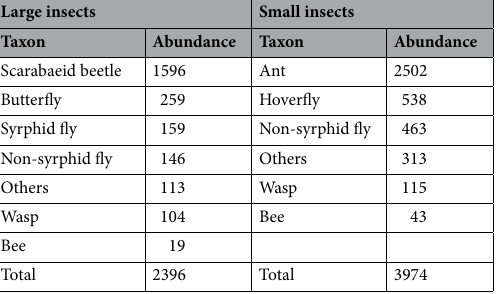
Table 1. Taxonomic composition of large and small insects observed visiting buckwheat flowers combined at all sites (14 buckwheat fields).